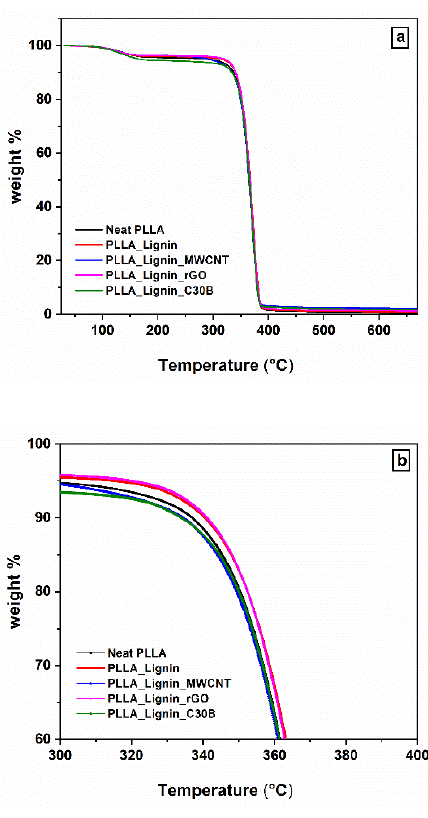
Polymers 2021 , 13 , x FOR PEER REVIEW Figure 2. TGA profiles for neat PLLA, PLLA with additive, and nanocomposites. Influence of the filler choice: ( a ) global profile ( b ) focus on the onset of the main degradation step.